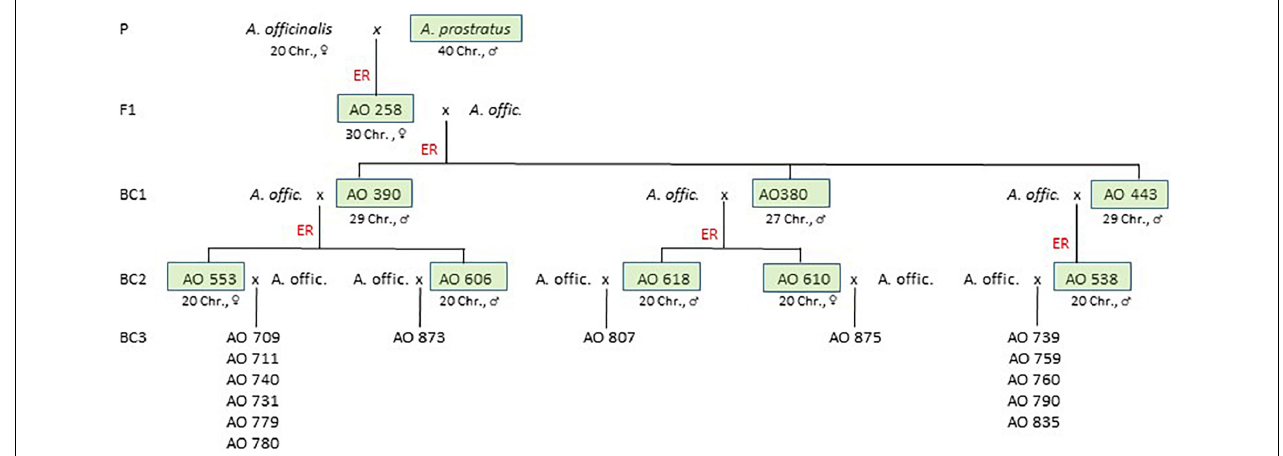
FIGURE 1 | Simplified pedigree of the introgression programme based on an interspecific cross between A. officinalis and A. prostratus reduced to relevant branches described in this article. Each of the A. officinalis parents at the cross generations of F 1 up to BC 2 generation represents a plant of an individual cultivar (compare Supplementary Tables 1 , 2 ). The A. officinalis parents of the BC 3 progenies represent plants of various cultivars listed in Table 1 and Supplementary Table 1 . The BC 3 progenies are seed-borne segregation populations analysed in this genetic study (boxes marked the AV-1-resistant cross parents, ER, embryo rescue; Chr,